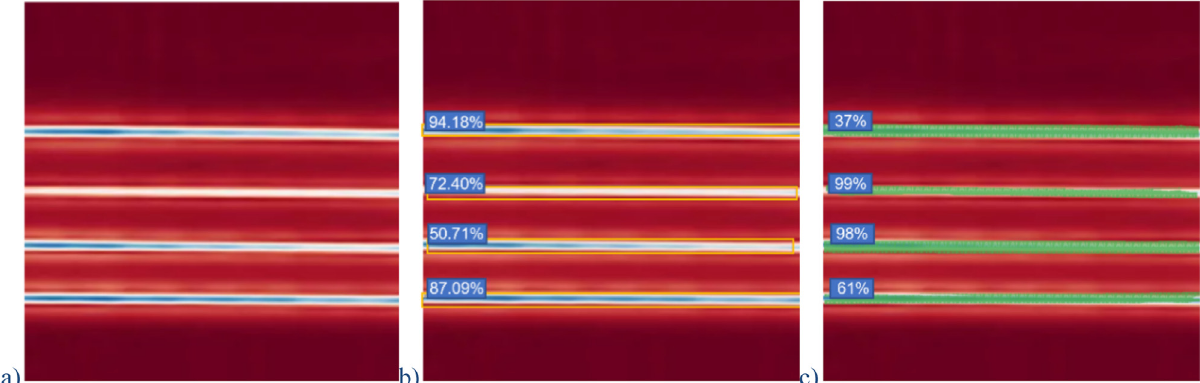
Fig. 6. Unlabeled image from test data set (a) bounding boxes done by object detection network with the according probabilities (b) and labels done by instance segmentation network